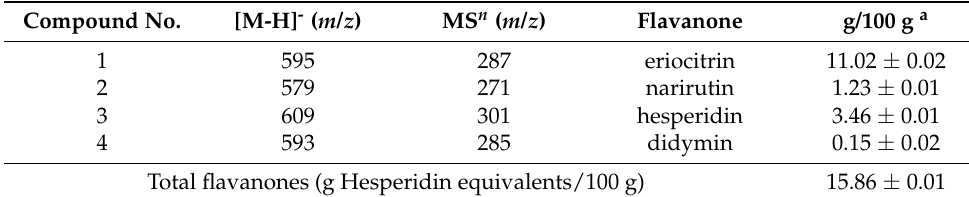
Table 2. Identification and concentration values of flavanones in RLE. Compound No.